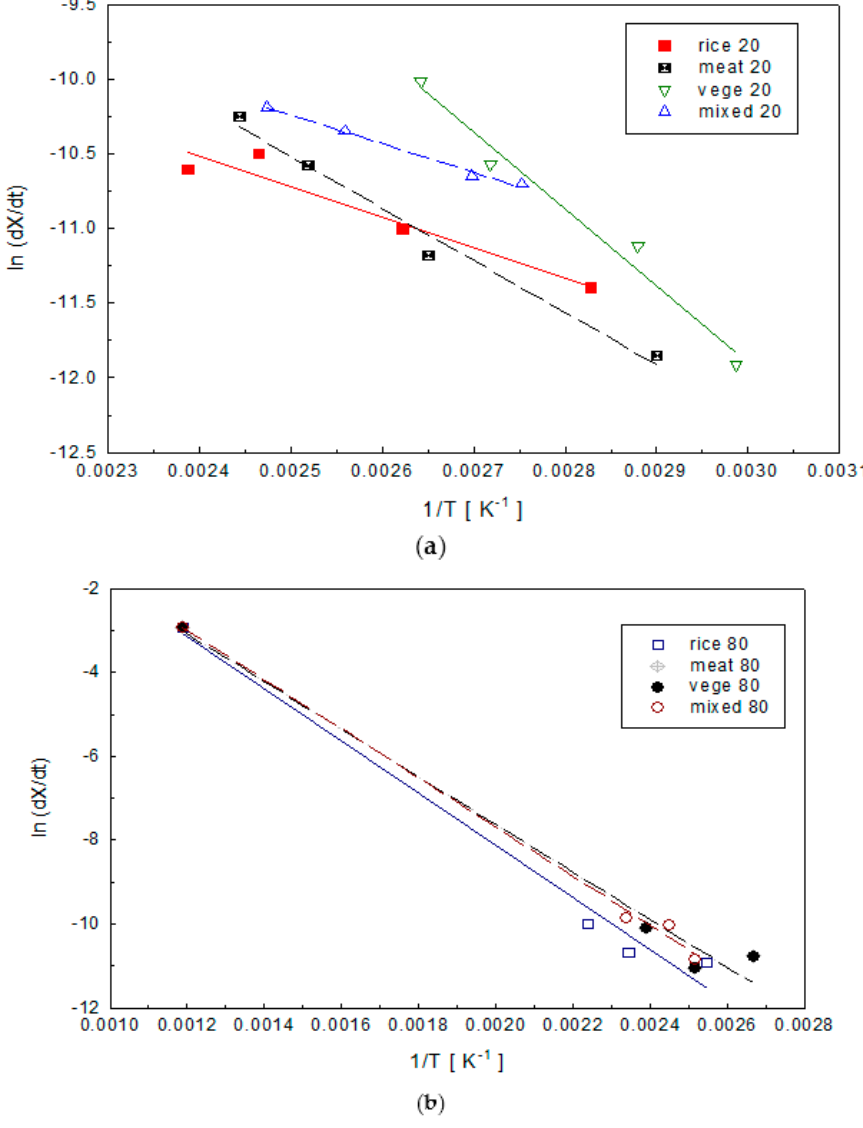
Figure 7. Application of Equation (5) with a heating rate 5, 10, and 20 ◦ C/min. The conversion values are ( a ) 20% and ( b ) 80%: 1, Rice: 20%; 2, Meat: 20%; 3, Vegetable: 20%; 4, Mixed: 20%; 5, Rice: 80%; 6, Meat: 80%; 7, Vegetable: 80%; and 8, Mixed: